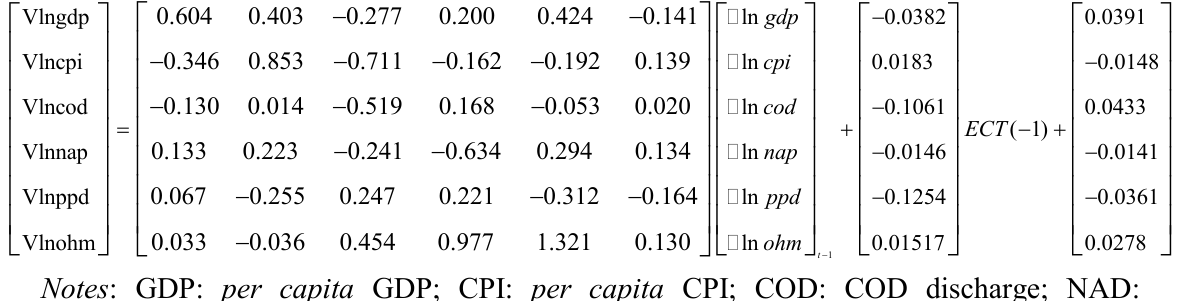
Figure 1 Results of the